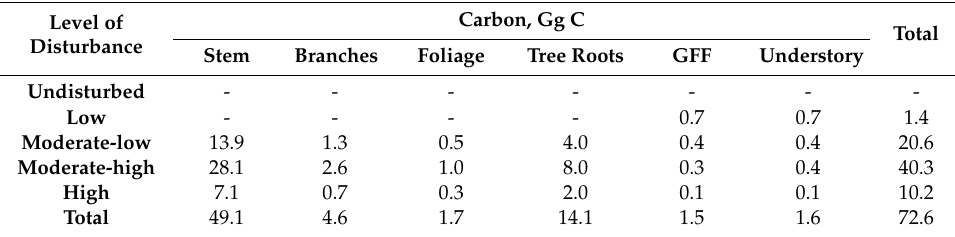
Table 7. The carbon loss in areas of illegal amber mining in